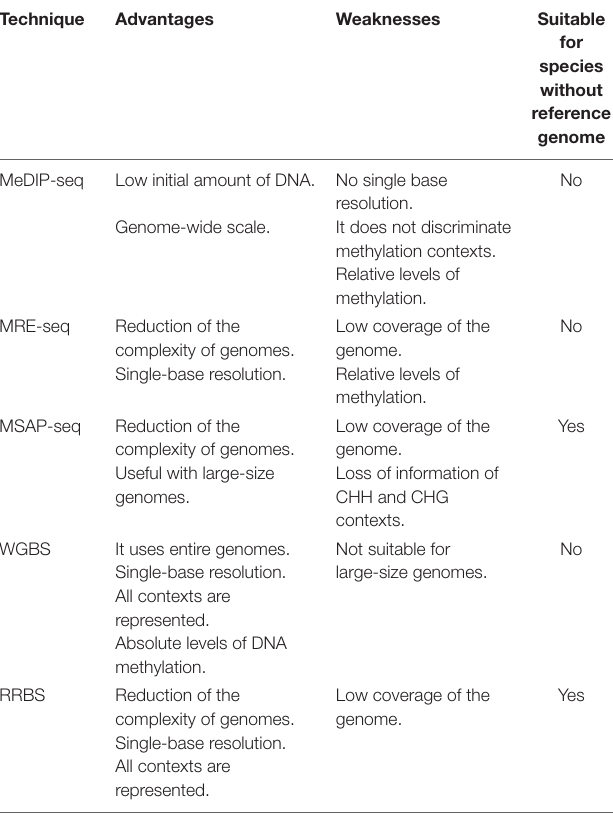
TABLE 1 | Summary of the advantages and weaknesses of the most relevant DNA methylation techniques and their suitability for species without reference genomes.